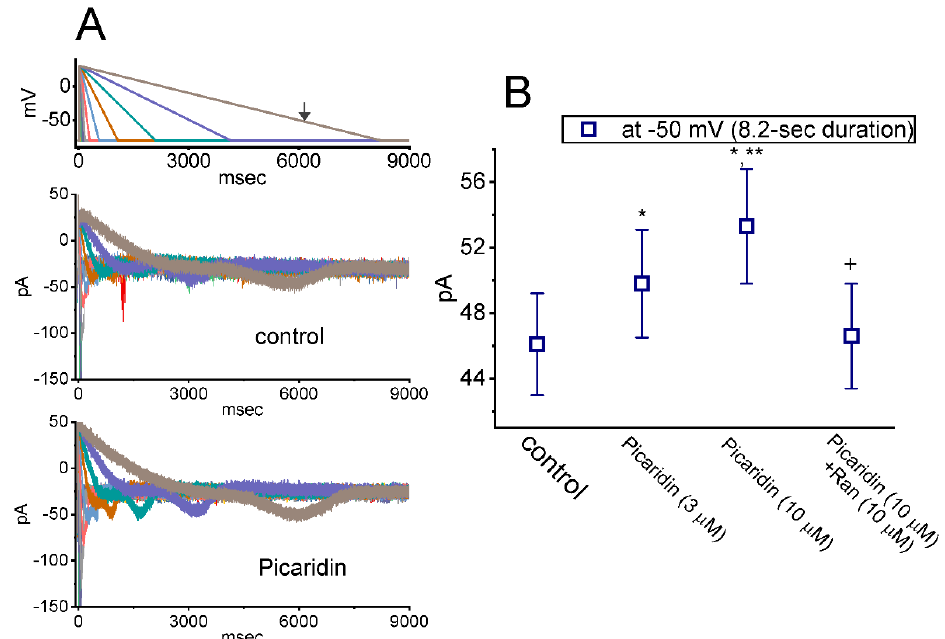
Figure 7. Augmentation by picaridin on resurgent I Na (I Na(R) ) evoked by the descending V ramp with varying durations. The examined cell was held at the level of −80 mV, and a 30 ms depolarizing pulse to +30 mV was imposed. Following brief step depolarization, the down-sloping V ramp from +30 to −80 mV, with varying duration in a geometric progressi on, was delivered to the cells. ( A ) In our voltage-clamp protocol, the different colors indicated in current traces (lower) correspond with those in potential traces (upper). Representative current traces obtained without (upper) or with (lower) the exposu re to 10 μM picaridin. The uppermost part is the voltage -clamp protocol given, and the arrow indicates the level of − 50 mV at which I Na(R) amplitude evoked by V ramp with a duration of 8.2 s was measured. ( B ) Summary graph demonstrating effects of picaridin (3 or 10 μM) and picaridin plus Ran on I Na(R) amplitude (mean ± SEM; n = 7 for each point). Current amplitude was measured at the level of −50 mV during the 8.2 -s descending V ramp . * This result is significantly different from control ( p < 0.05), ** Significantly different from picaridin (3 μM) alone group ( p < 0.05), and + Significantly different from picaridin (10 μM) alone group ( p < 0.05).